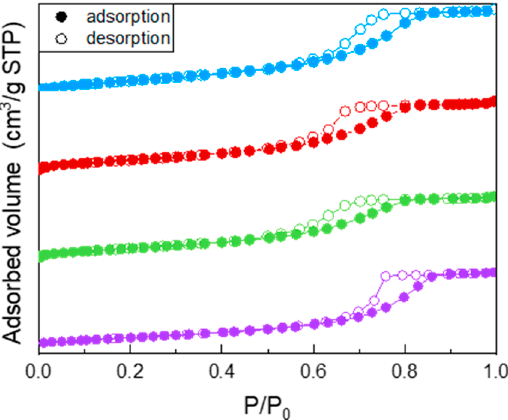
Figure 1. N 2 adsorption/desorption isotherms at − 196 ◦ C obtained with the following samples: undoped TiO 2 (purple circles), Fe(3.5)-TiO 2 (green circles), Fe(2.5)-TiO 2 (red circles), Fe(1.0)-TiO 2 (light blue circles). Table 2. Some relevant structural and textural properties of the studied samples as obtained by X-ray powder Diffraction (A = anatase) and N 2 isotherms at − 196 ◦ C. Band gap energy values, as obtained from DR UV–Vis spectra by applying different methods suggested by literature. Values of pH IEP (pH at the isoelectric point), as obtained by ζ -potential measurement. Crystallite Sample